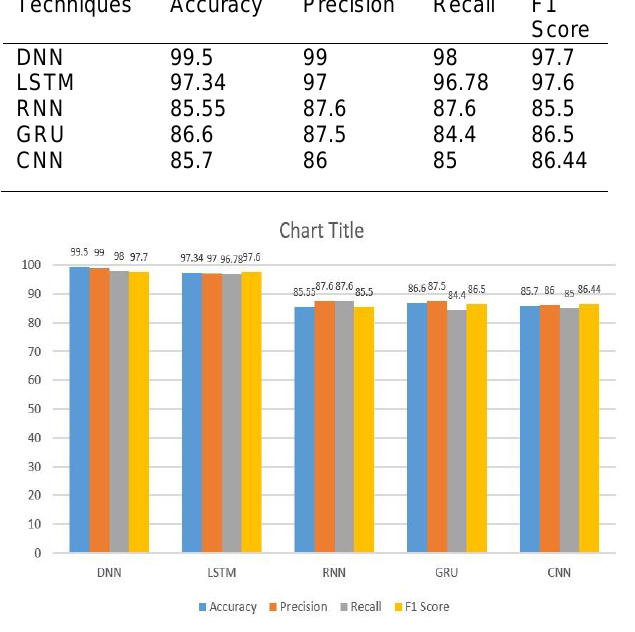
Table below Analysis of individual labels (Benign and Anomaly) with regard to accuracy, reminder and F1 score percentages. We have seen that all techniques showed